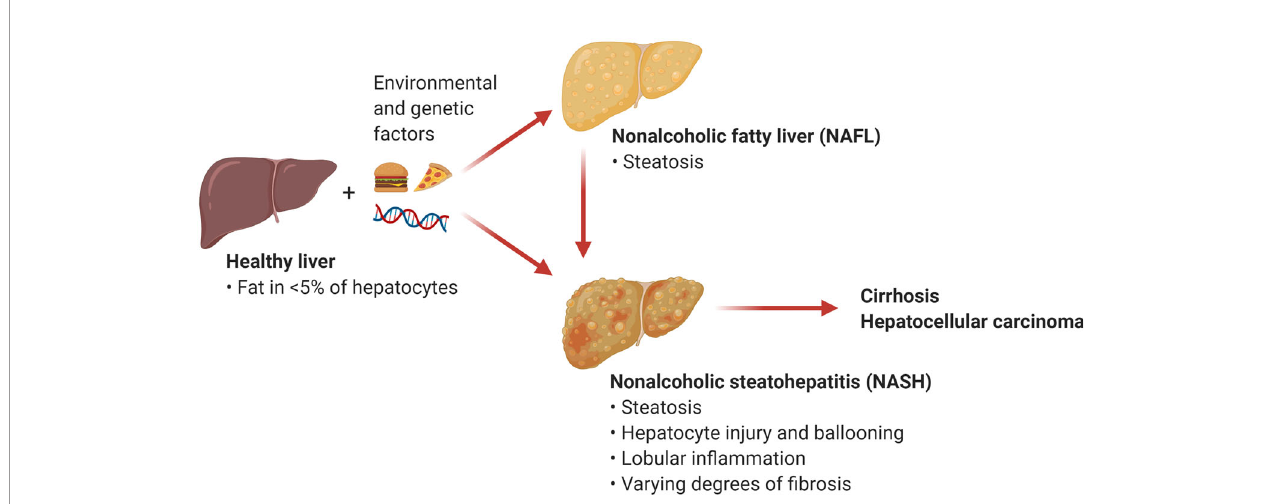
FIGURE 1 | Nonalcoholic fatty liver disease (NAFLD). NAFLD encompasses a spectrum of hepatic manifestations such as nonalcoholic fatty liver (NAFL) and nonalcoholic steatohepatitis (NASH) that develop on the background of genetic and environmental factors including excess calories and sedentary lifestyle. NASH is a progressive condition that can advance to cirrhosis and hepatocellular carcinoma. (Created with